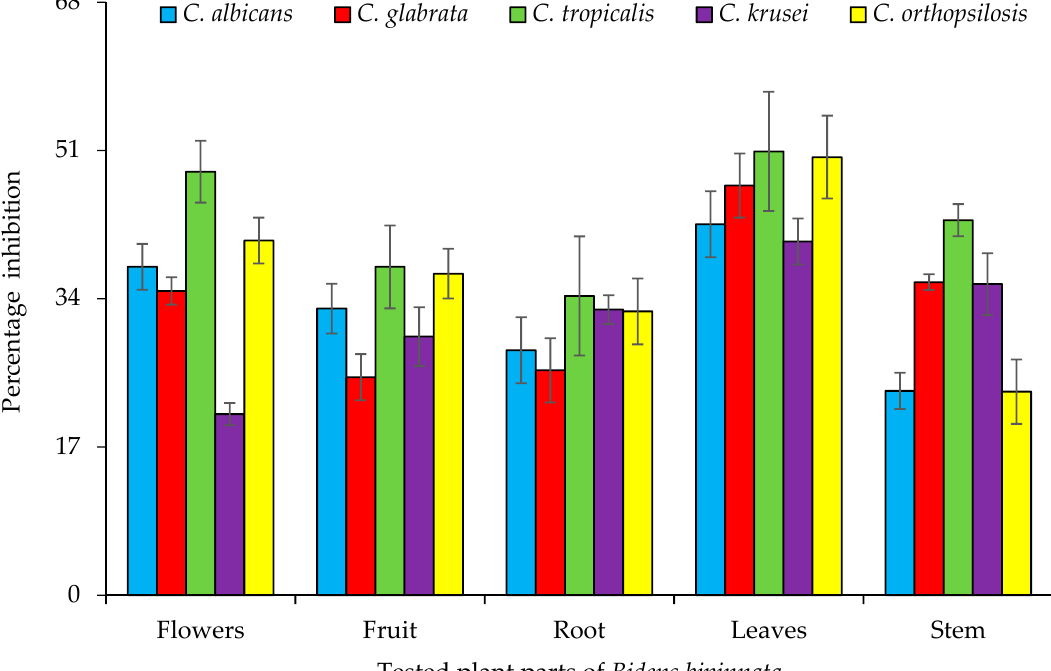
Figure 3. Anticandida activity of Hexane extract of different parts of Bidens bipinnata. The fractions obtained from the silica column were tested against C. albicans and activity was observed in fractions 25–29 and 89–92. All active fractions were dried, weighted and again tested for anticandida activity using a serial dilution protocol and persistent activity was observed in fraction 25–29, indicating the presence of active anticandida compounds (Figure 4). Fraction 27 was further separated using HPLC-DAD Analysis with water: acetonitrile mobile phase (starting at 15% acetonitrile for 5 min and linearly increasing to 100% over 35 min). The chromatogram recorded well-resolved peaks at 254 nm (Figure 5). All 60 one-minute fractions were collected and re-tested for anticandida activity.